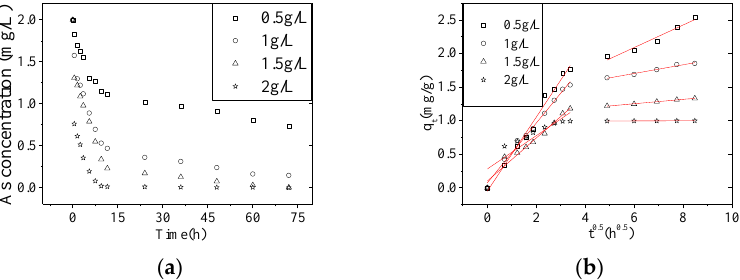
Figure 3. The As(V) removal rate as function of adsorbent concentration. ( a ) Effect of varying the adsorbent concentration on as function of time. ( b ) Intraparticle diffusion model fit for the As(V) removal rate by NZVI/AC at various adsorbent dosages (conditions: C 0 = 2.0 mg/L, pH = 6.5, 150 rpm, 20 × 40 mesh particle size, t = 72 h, T = 298 K, adsorbent dosage: 0.5–2.0 g/L). Table 3. Rate constants for the kinetic model of the adsorption of As(V) on NZVI/AC at different adsorbent dosages. Parameter